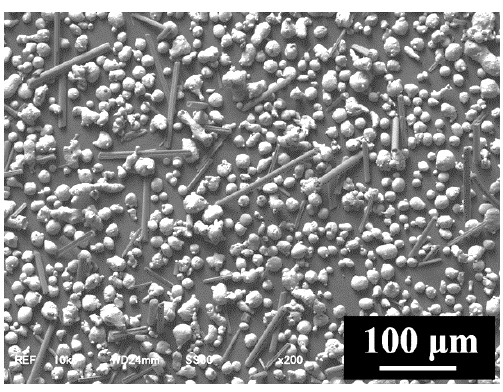
Figure 2. Scanning electron microscope (SEM) image of C/Al mixed powder.